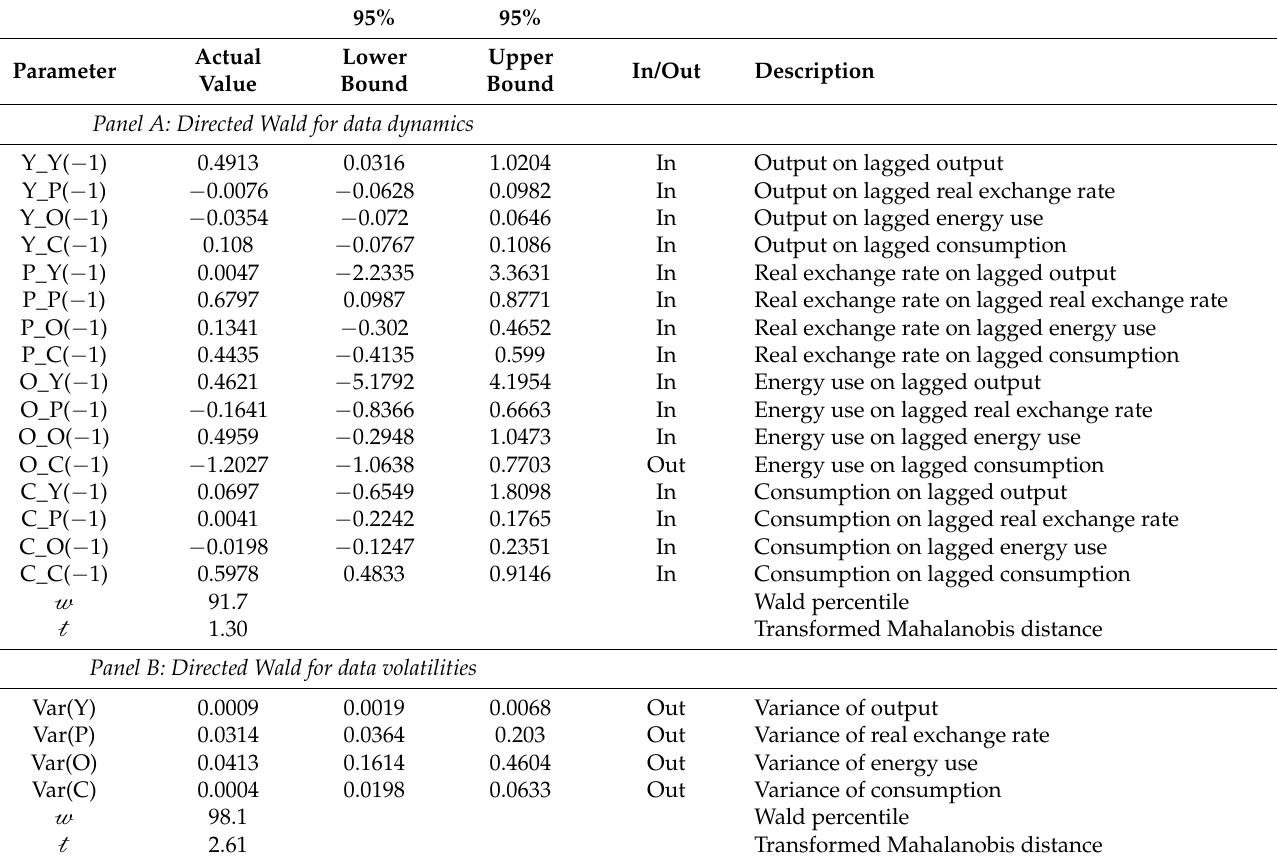
Table 4. Auxiliary model (VAR) coefficients and bootstrap